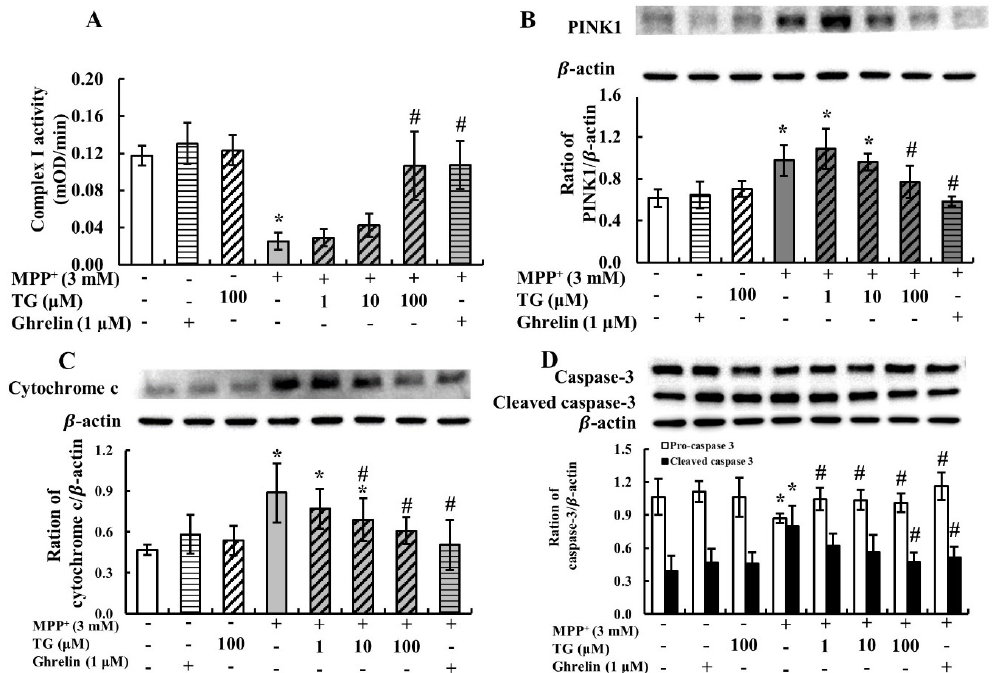
Figure 2. Teaghrelin (TG) attenuated 1-methyl-4-phenylpyridinium (MPP + )-induced mitochondrial dysfunction and apoptosis in SH-SY5Y cells. SH-SY5Y cells were treated with TG or ghrelin in the presence or absence of MPP + for 24 h. After various treatments, mitochondrial complex I activity was measured at 450 nm using a microplate reader ( A ). Cells were harvested and analyzed through Western blotting using antibodies against phosphatase and tensin homologue-induced kinase 1 (PINK1) ( B ), cytochrome c ( C ), and caspase-3 ( D ). The expression of β -actin was used as the internal control. Results were analyzed with one-way analysis of variance. Values are presented as the mean ± standard deviation ( n = 3). * p < 0.05 compared with the control group, # p < 0.05 compared with MPP + alone. -: untreated with drugs or compounds, + : treated with drugs or